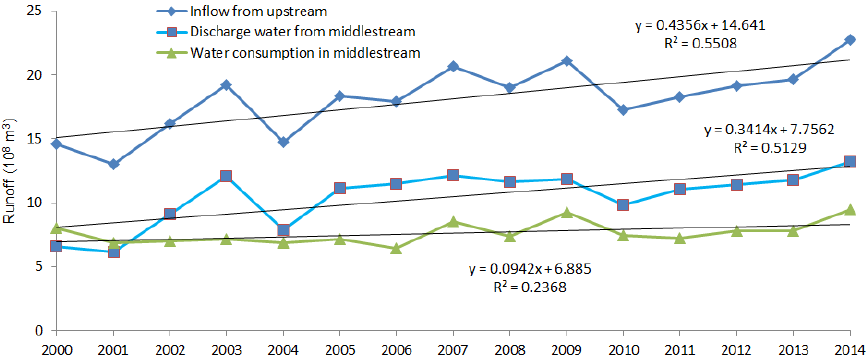
Figure 12. Changes in the upstream inflow and midstream consumption in the HRB.